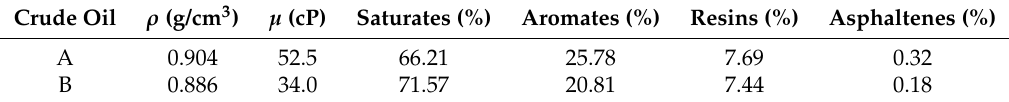
Table 3. Crude oil properties measured at 21.5 ◦ C and the SARA analysis (normalized wt %). Crude Oil ρ (g/cm 3 ) µ (cP) Saturates (%) Aromates (%) Resins (%) Asphaltenes (%) A 0.904 52.5 66.21 25.78 B 0.886 34.0 71.57